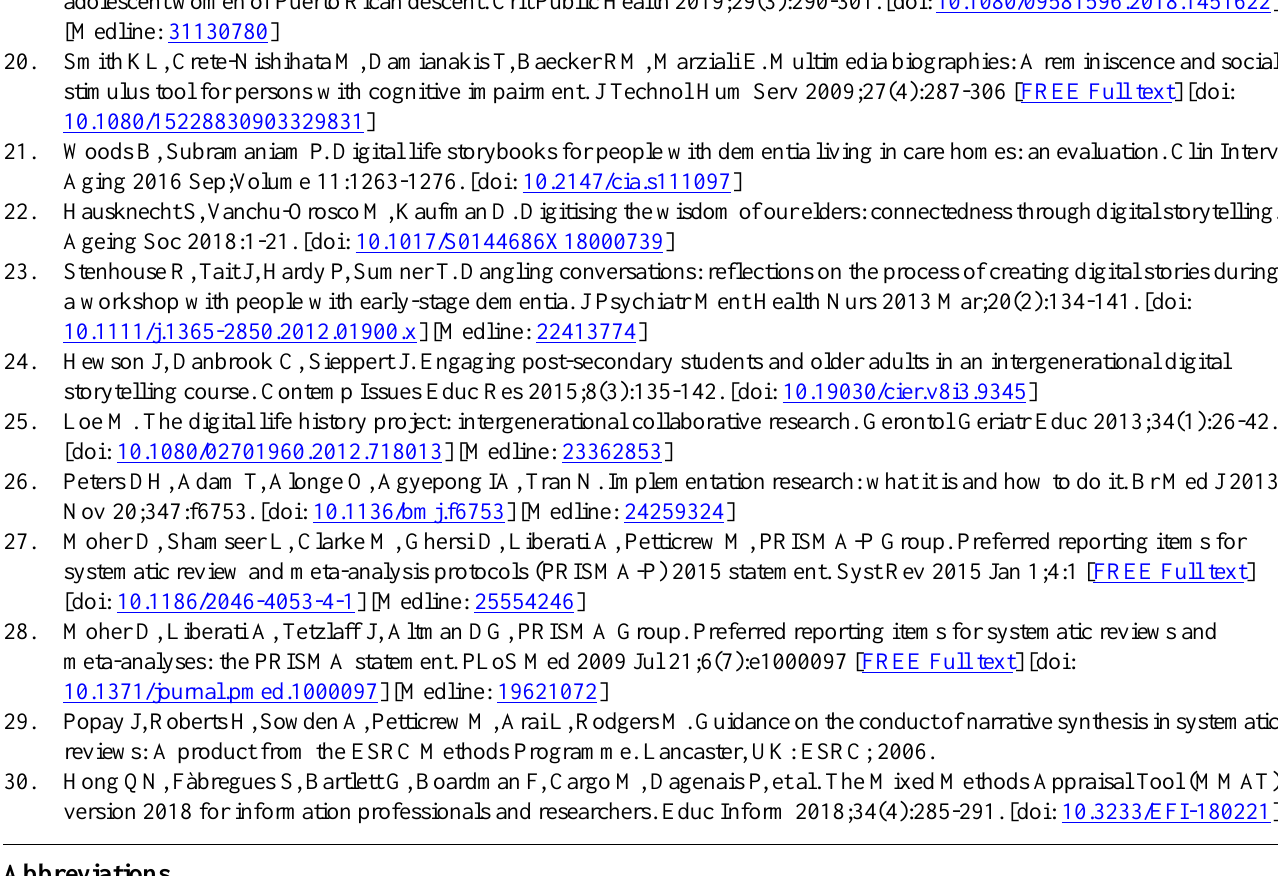
MMAT: Mixed Methods Appraisal Tool PRISMA: Preferred Reporting Items for Systematic Reviews and